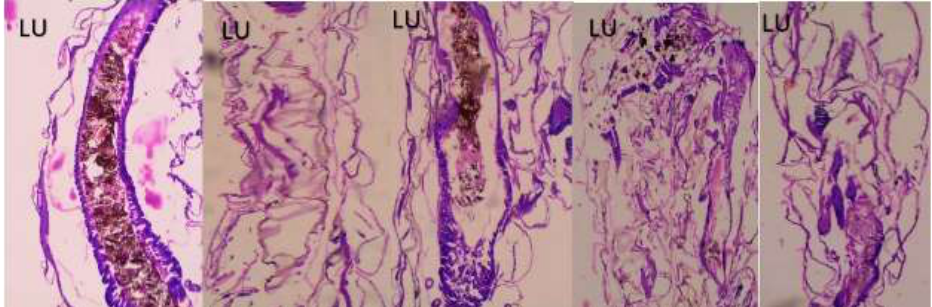
Figure 8. Longitudinal section and midgut lumen of an Aedes aegypti larva exposed to different concentrations of Pantoea stewartii -mediated silver nanoparticles.